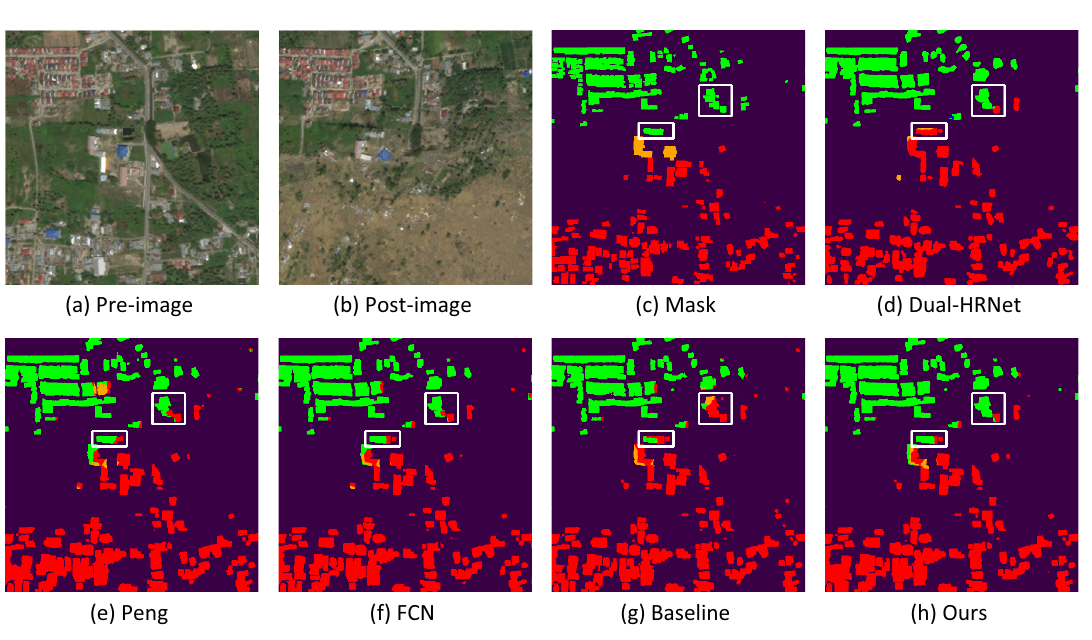
Figure 8. Classification of building damage in